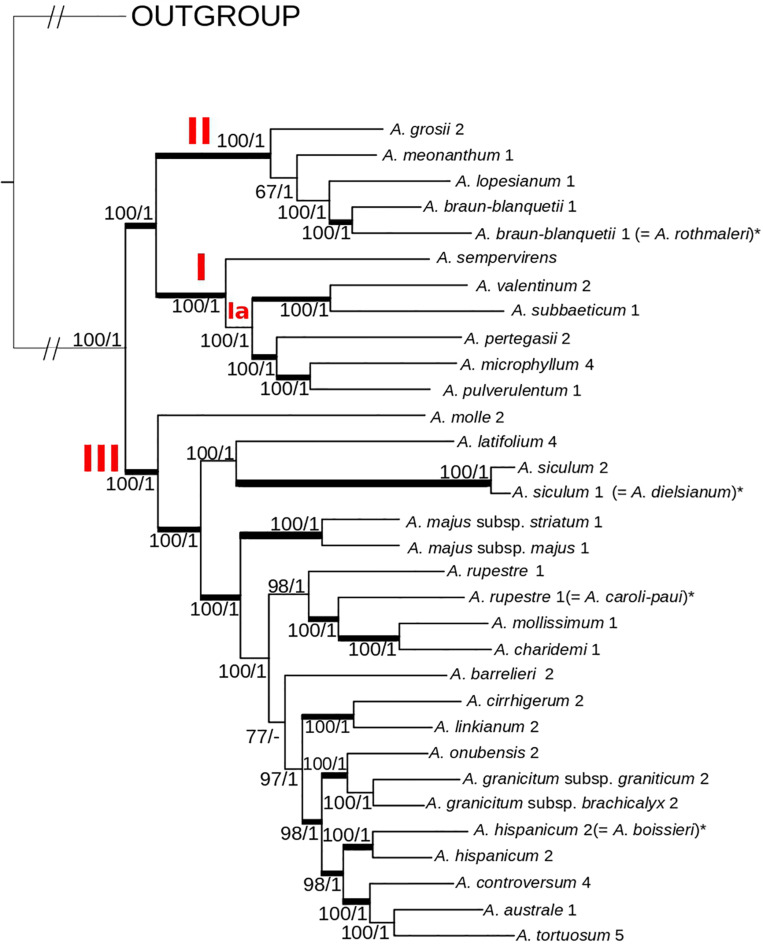
Phylogenetic relationships of the 26 Antirrhinum species herein recognized based on concatenated DNA sequences of 4,016 genotyping-by-sequencing loci (c90m6 dataset) obtained from topotypic specimens. The best scoring maximum likelihood tree from RAxML analysis is shown. The three major clades (I–III) and a subclade (Ia) are indicated in red letters. Values at branches are bootstrap support values from the maximum likelihood (RAxML) analysis followed by posterior probabilities from the Bayesian (ExaBayes) analysis. Thicker branches are also supported by coalescent-based analyses in SVDquartets. An asterisk (*) at some taxon names (in brackets) indicates current synonyms for particular species. Further voucher information for each specimen is detailed in Supplementary Table 1 of the Supplementary Files.